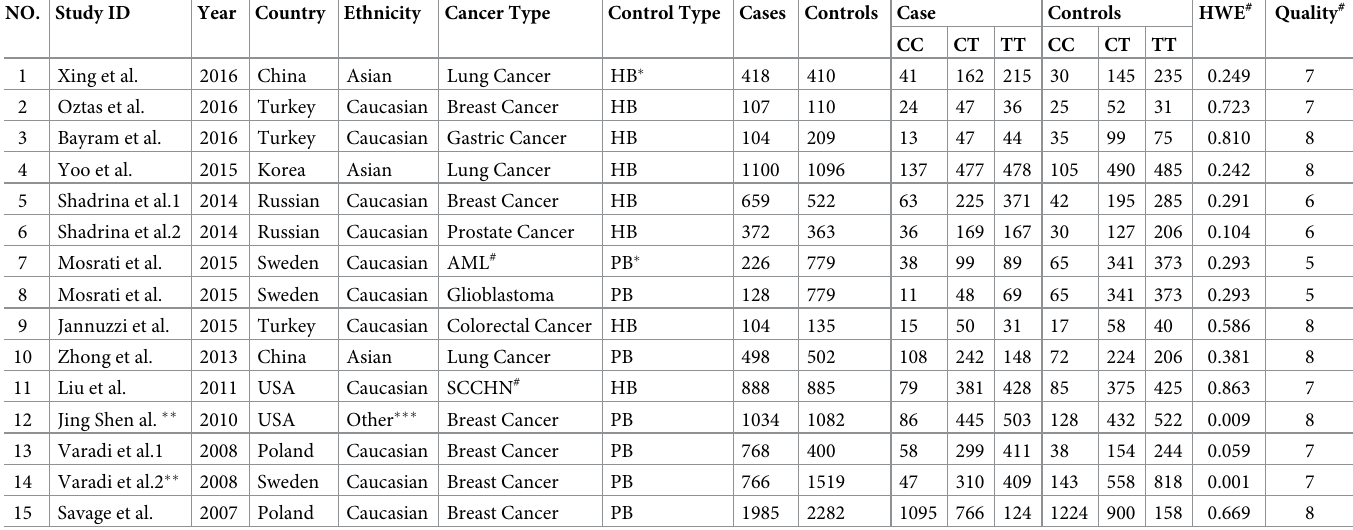
Table 1. Characteristics of the studies included in the